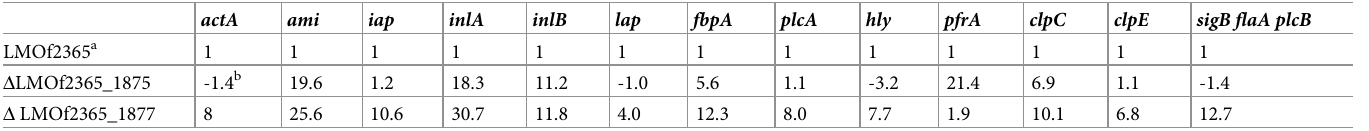
Table 3. Relative expression levels of virulence and stress-related genes in wild-type and deletion mutants of L . monocytogenes